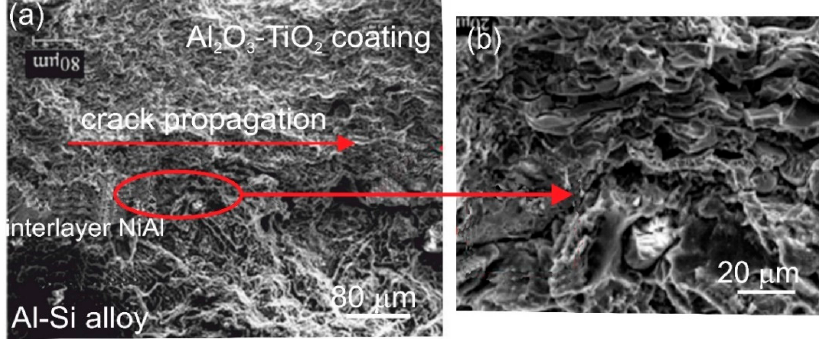
Figure 10. ( a ) Scanning micrographs of the fracture surface of the HVOF sprayed Al 2 O 3 -15 wt.% TiO 2 coating with the NiAl interlayer on the Al-Si cast alloy after bend test, ( b ) magnified area selected in Figure 10a.